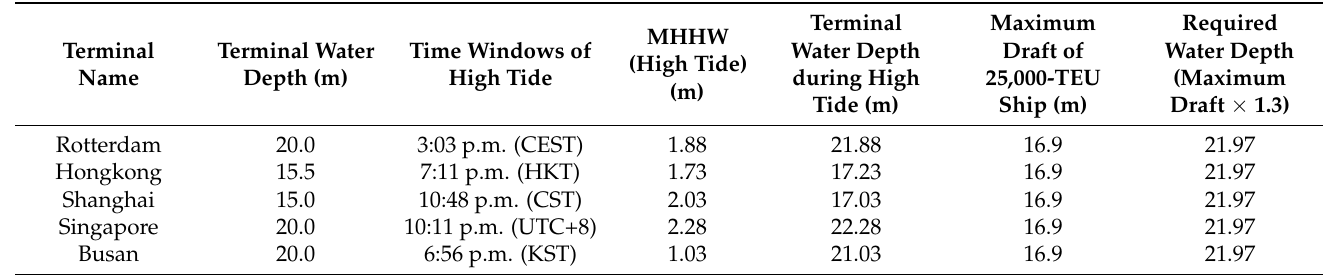
Table 10. Terminal water depth at high tide and required water depth for 25,000-TEU container ship (Park and Suh [4]).